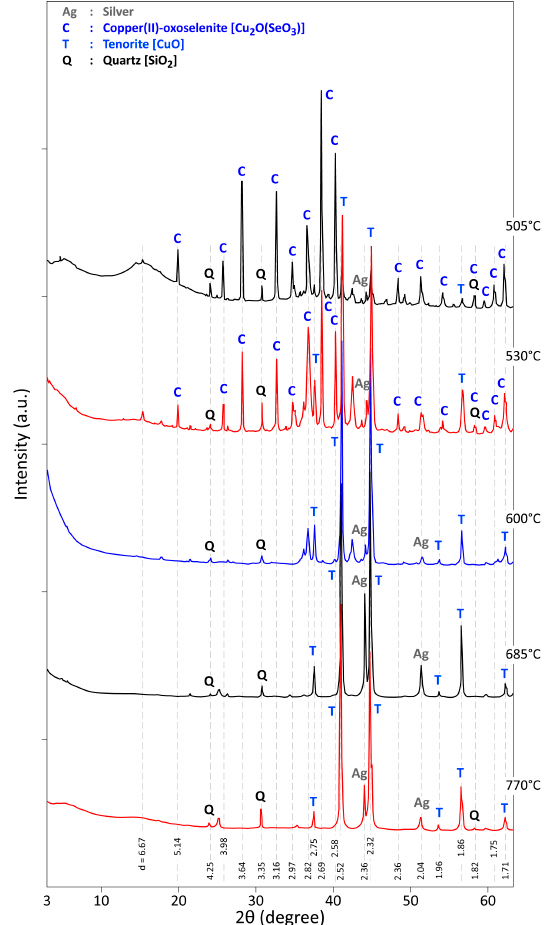
Figure 6. XRD patterns of the residues obtained during CAS sample treatment under air from 505 ◦ C to 770 ◦